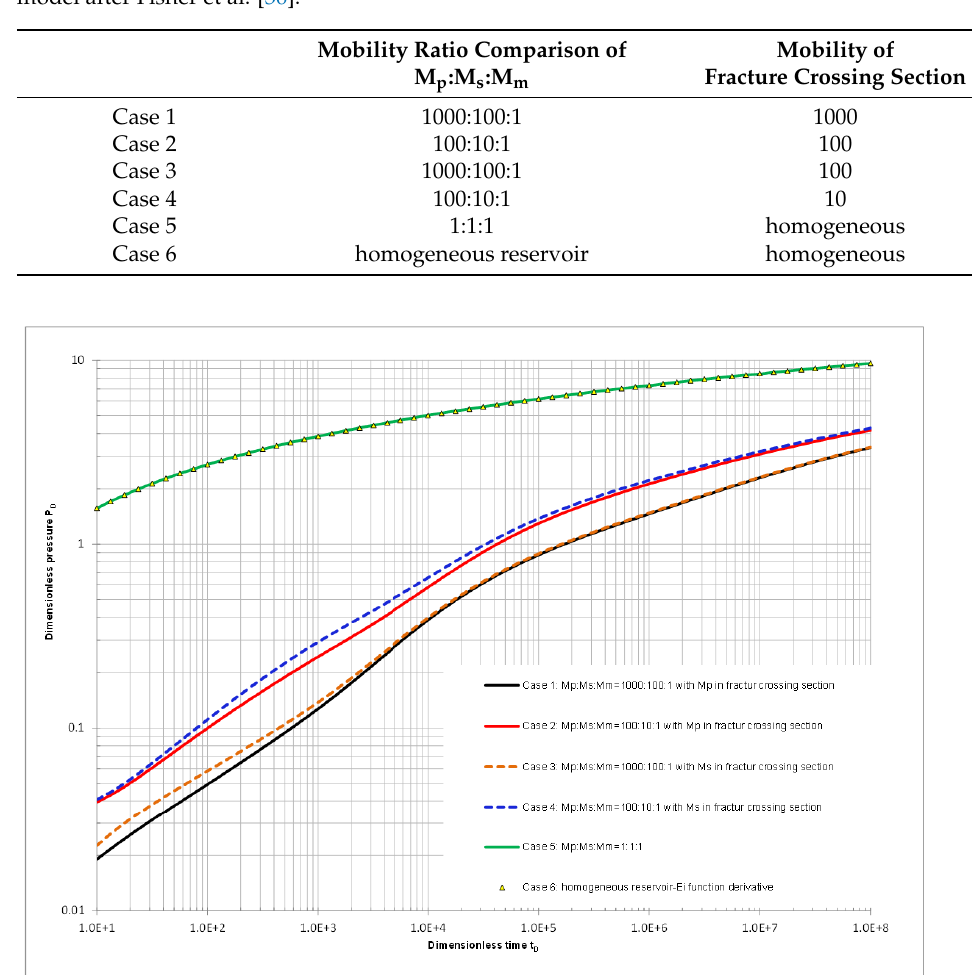
Figure 25. P D for the six cases based on the simplified fracture network model.